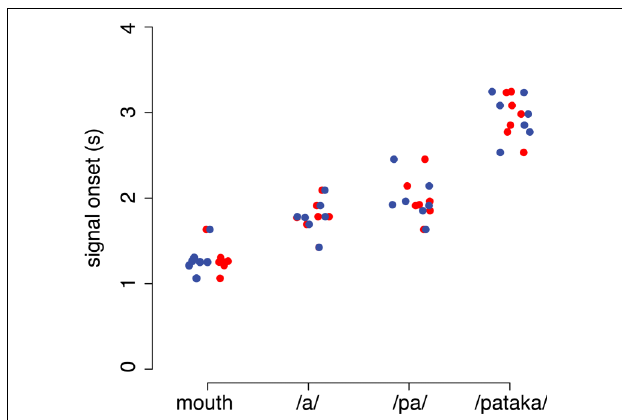
FIGURE 9 | Inter-individual variability of signal onset. Individual data is shown for all four experimental conditions. Mouth denotes the opening of the mouth without articulation. /a/, /pa/, /pataka/ denote the overt production of the respective utterance. Data of younger participants are shown in red, of older participants in blue. Average signal onset times in the younger participants were (mean ± SD): 1.27 ± 0.17 s (mouth), 1.77 ± 0.20 s (/a/), 1.97 ± 0.26 s (/pa/) and 2.94 ± 0.26 s (/pataka). Signal onset times in the older participants were: 1.09 ± 0.18 s (mouth), 1.50 ± 0.17 s (/a/), 1.71 ± 0.31 s (/pa/) and 2.80 ± 0.42 s (/pataka/). Signal onset times were not signifi cantly different between age groups